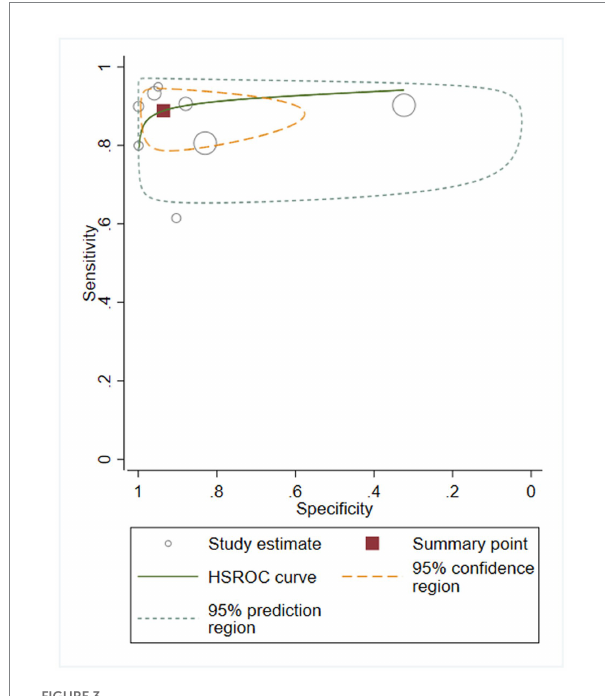
FIGURE 3 Hierarchical summary receiver operator characteristic (SROC)